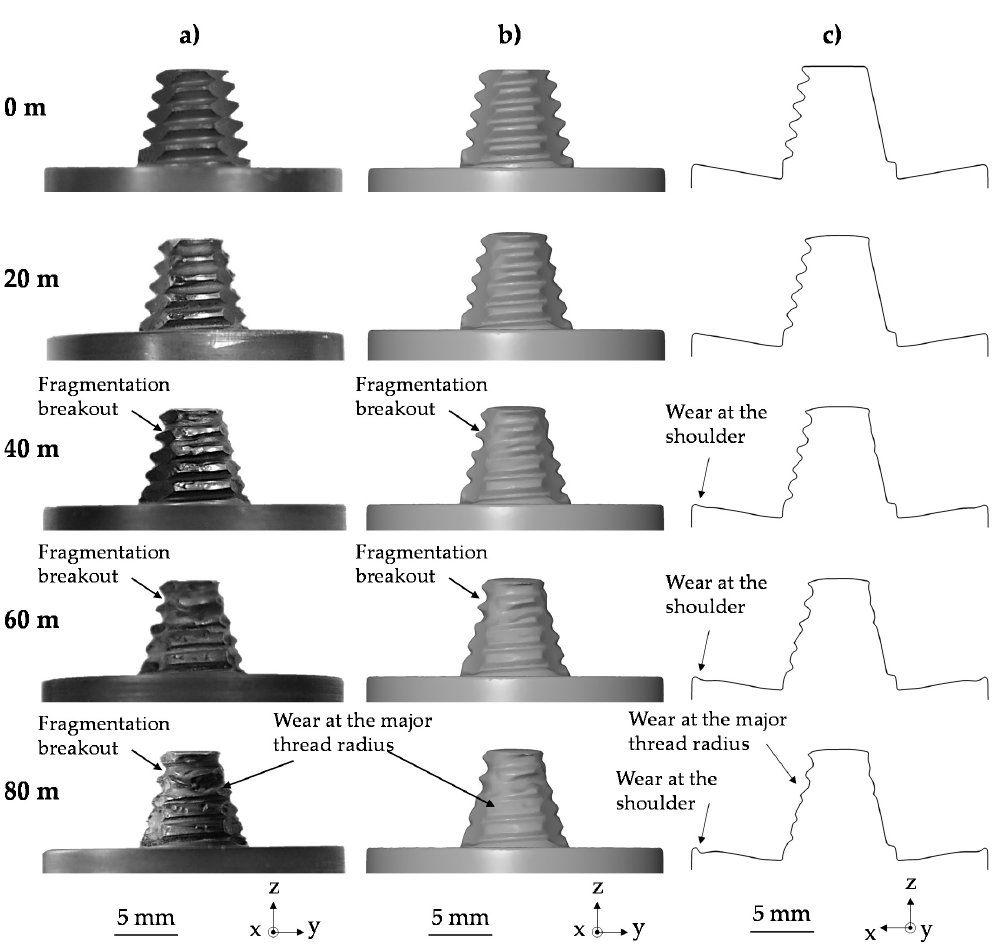
Figure 6. Qualitative inspection of the FSW tools by photographic images ( a ), stripe light projection ( b ), and stripe light projection in the full section view ( c ).